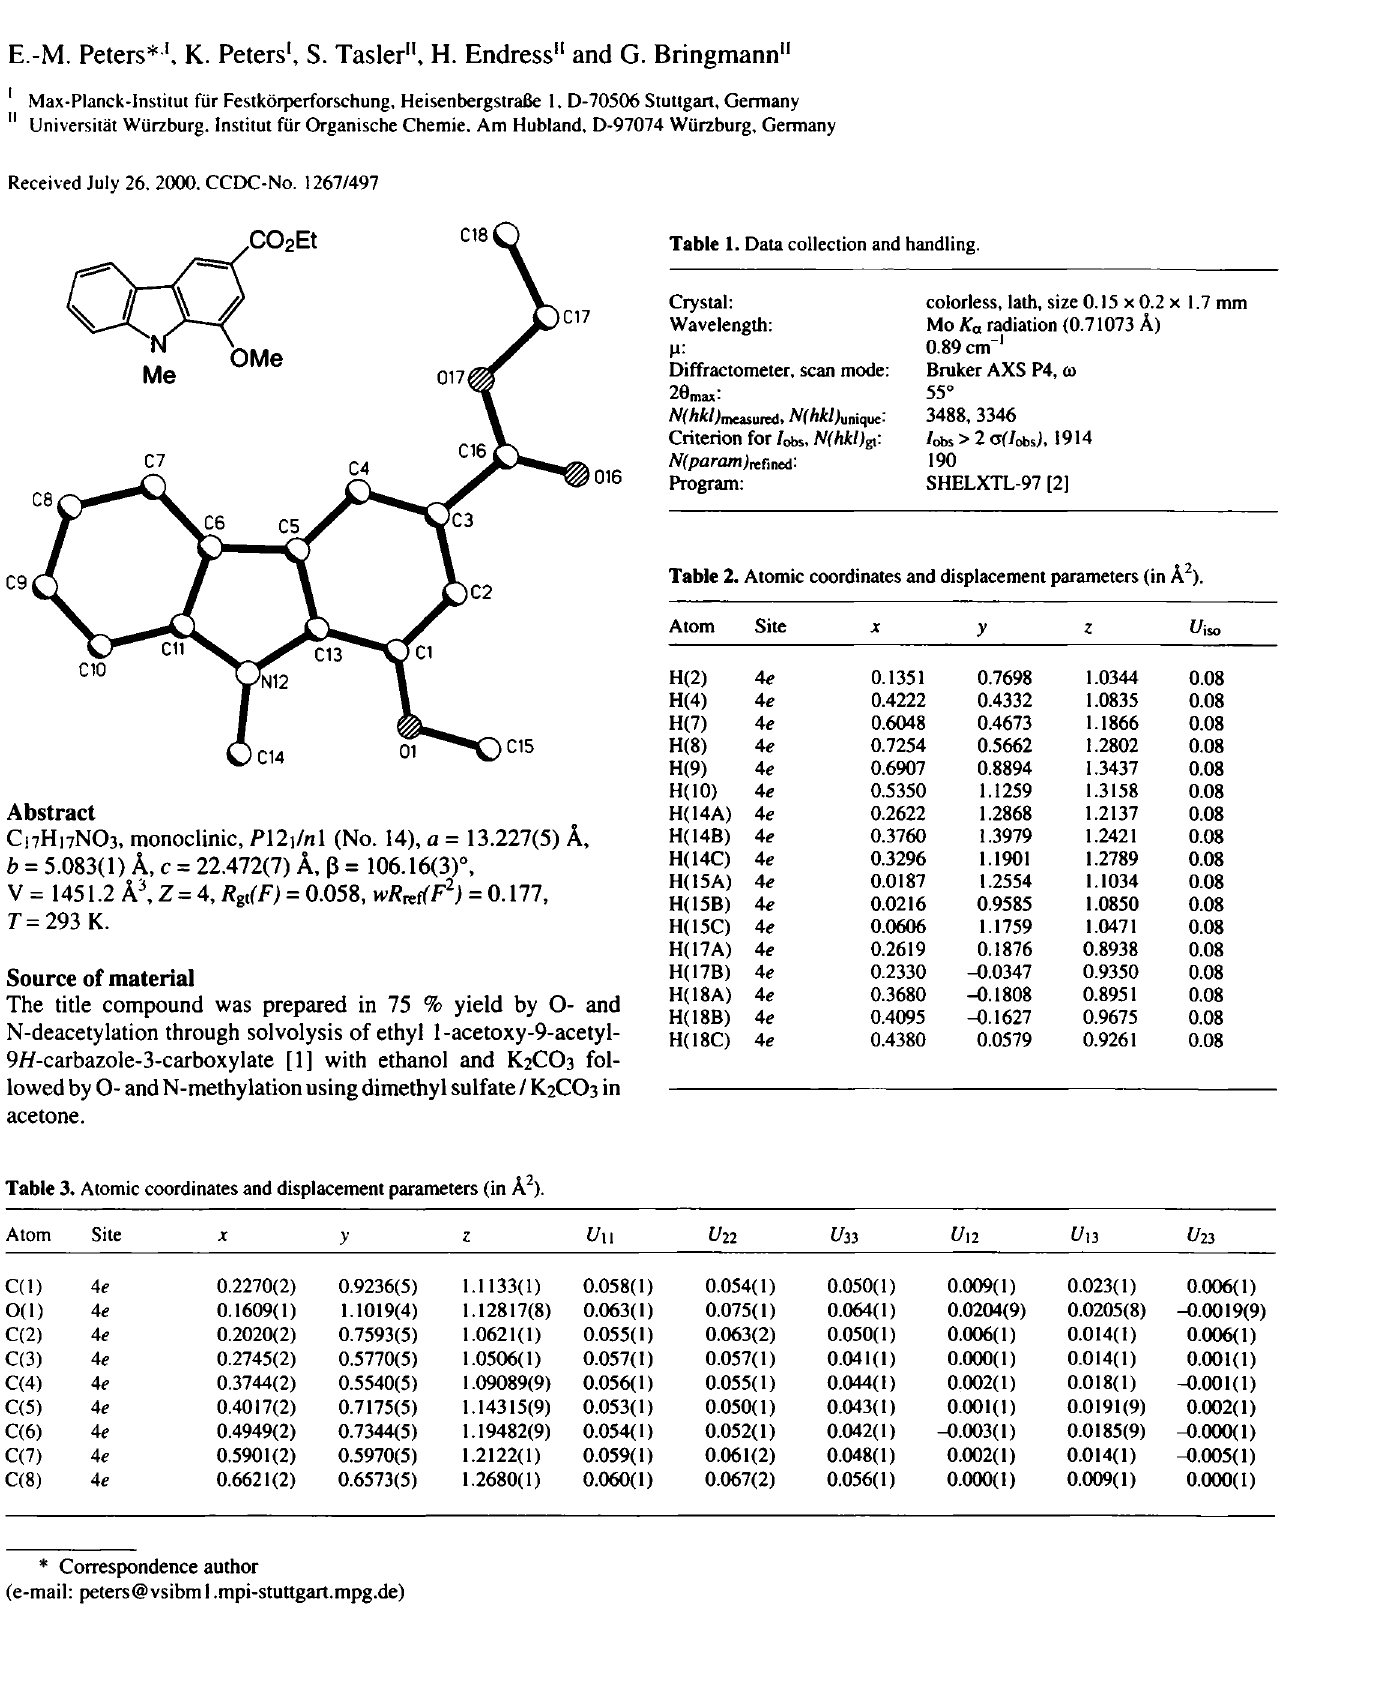
Table 1. Data collection and handling.